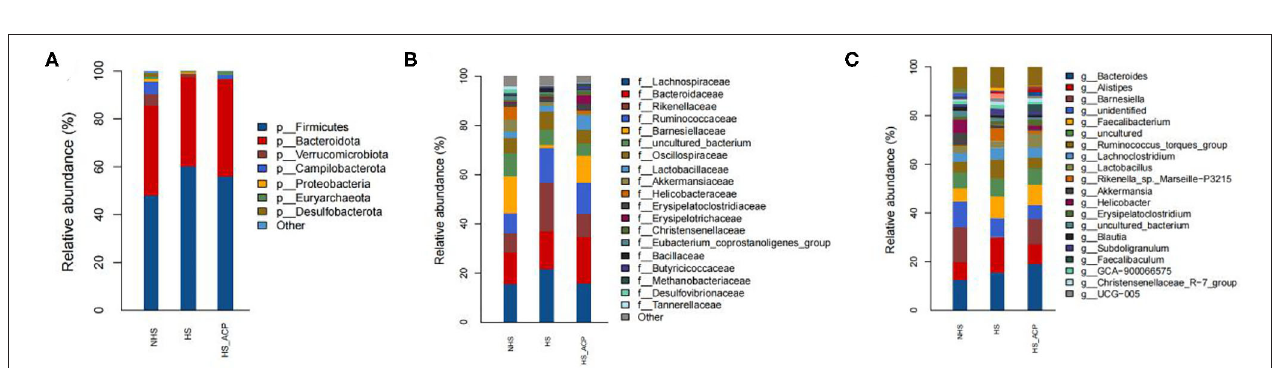
FIGURE 7 | Relative abundance of microbiota at the (A) Phylum, (B) Family, and (C) Genus level.